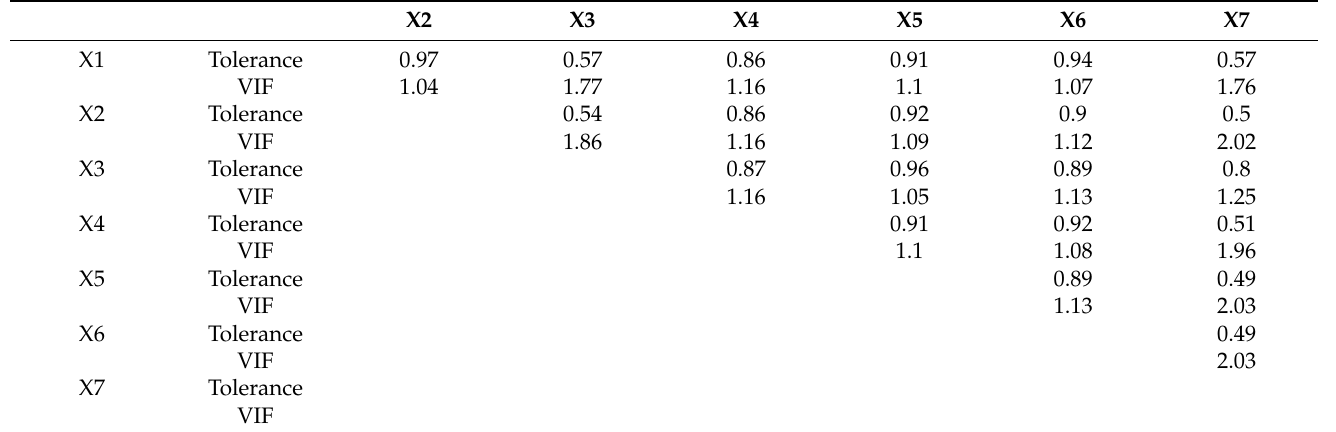
Table A2. Variance inflation factors (VIFs) for the independent variables in the ordinal regression